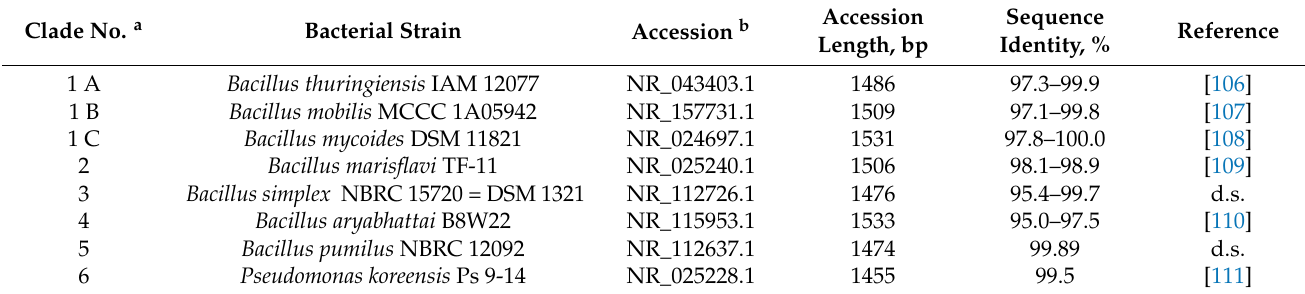
Table A1. Results of bacterial isolate identification using 16S rRNA gene sequence data.